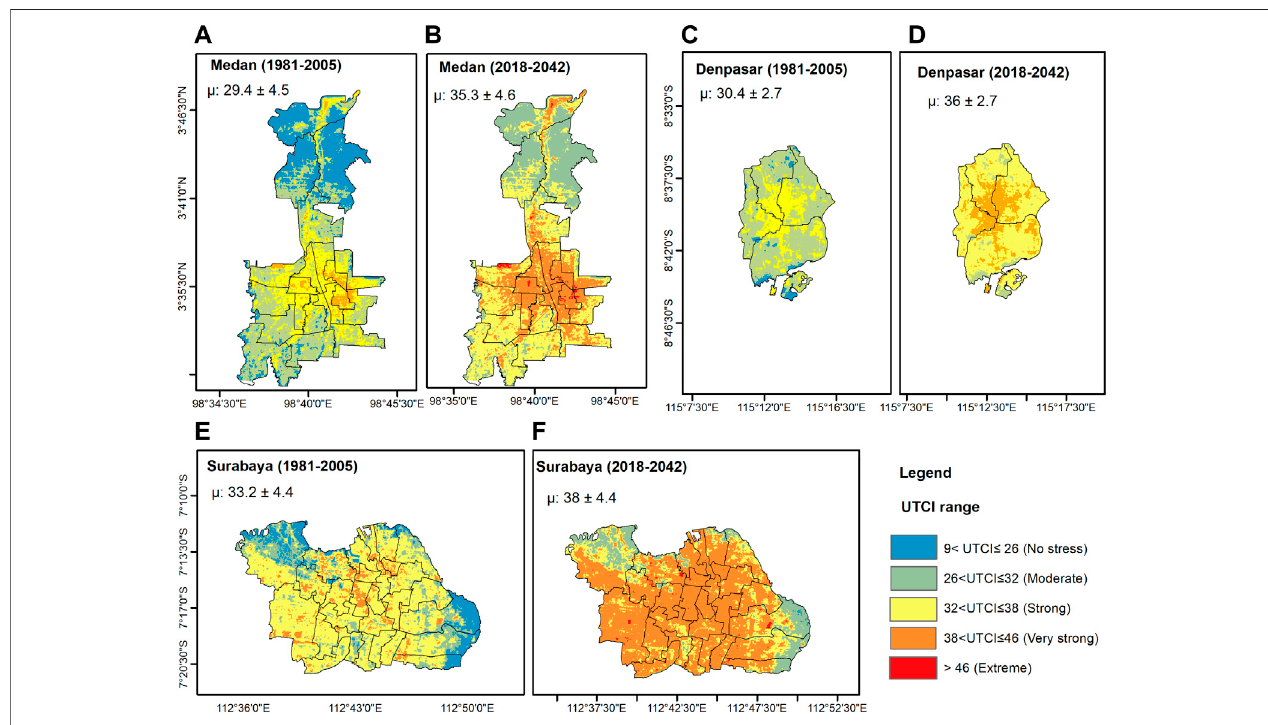
FIGURE9| UTCIspatialdistributioninDenpasar,Medan,andSurabayacities,extremeCCscenario.The (A,C,E) refertothebaselineperiodofMedan,Denpasar, and Surabaya, while (B, D, F) are the future period of Medan, Denpasar, and Surabaya under extreme CC scenario.